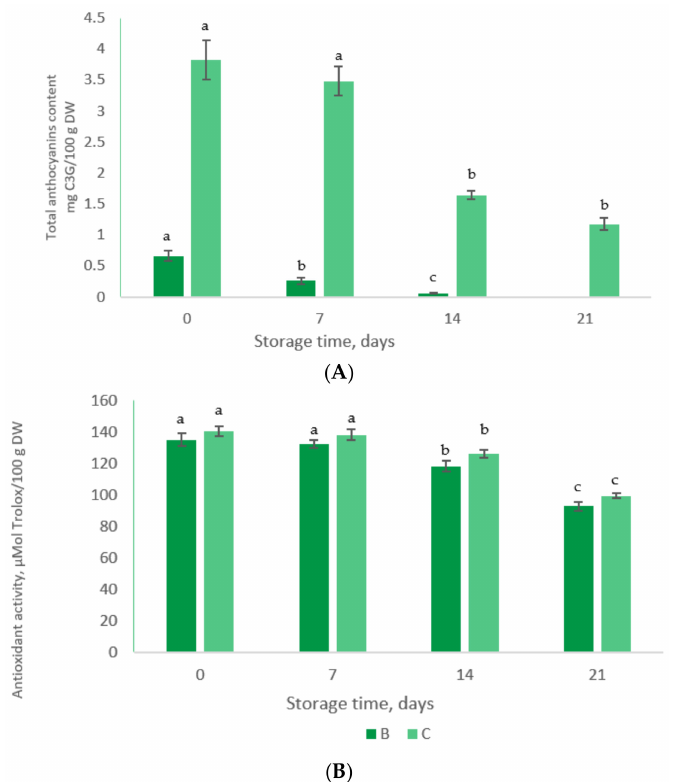
Figure 3. The stability of anthocyanins ( A ) and antioxidant activity ( B ) in yoghurt samples during storage test. Superscripts that for the same sample do not share the same letter (a, b, c) are statistically significant at p <